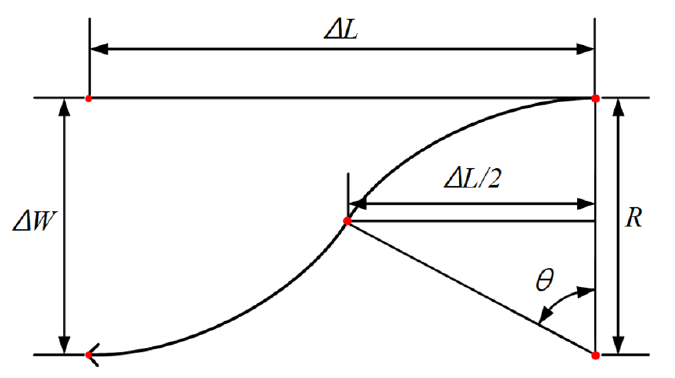
(cid:0) (cid:1) Figure 10. Reduced exposure ∆𝑊 due to an additional (𝑆 (cid:2878) 𝑅 (cid:2879) 𝐿 (cid:2879) ) action. S + R − L − Figure 10. Reduced exposure ∆ W due to an additional action. In Equation (19), θ is expressed as Equation (20) from the turning radius R and the In Equation (19), 𝜃 is expressed as Equation (20) from the turning radius 𝑅 and the lengthwise clearance ∆ L inside the parking spot. lengthwise clearance ∆𝐿 inside the parking spot.